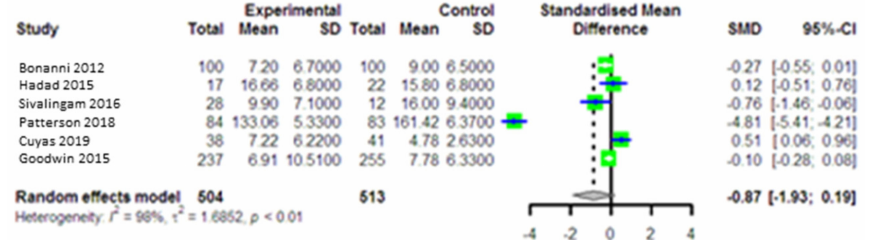
Figure 2. Forest plot of the meta-analysis comparing plasma insulin levels between intervention and control groups. SMD: standardized mean difference, SD: standard deviation, CI: confidence intervals.